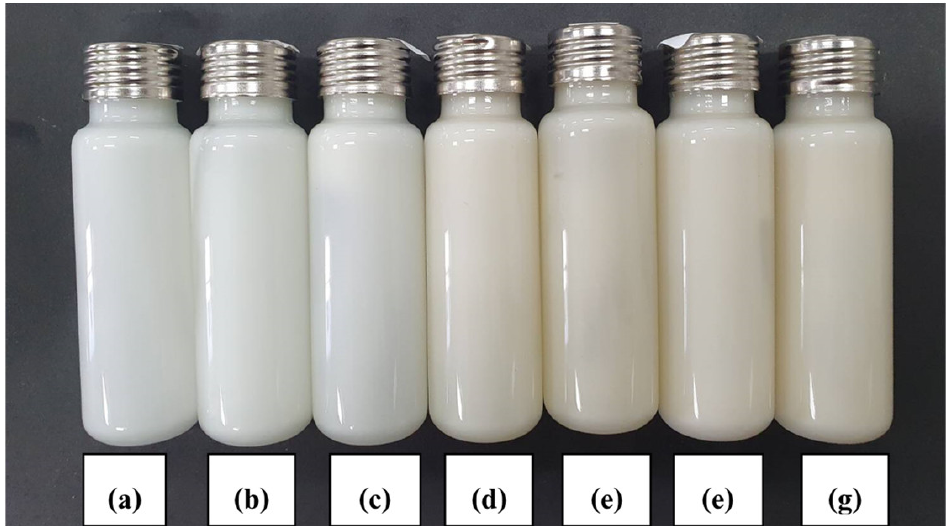
Figure 3. Deodorant cream with 1.0% H-CMCH by heating/cooling cycle; ( a ) cycle 0, ( b ) cycle 1, ( c ) cycle 2, ( d ) cycle 3, ( e ) cycle 4, ( f ) cycle 5, and ( g ) cycle 6.